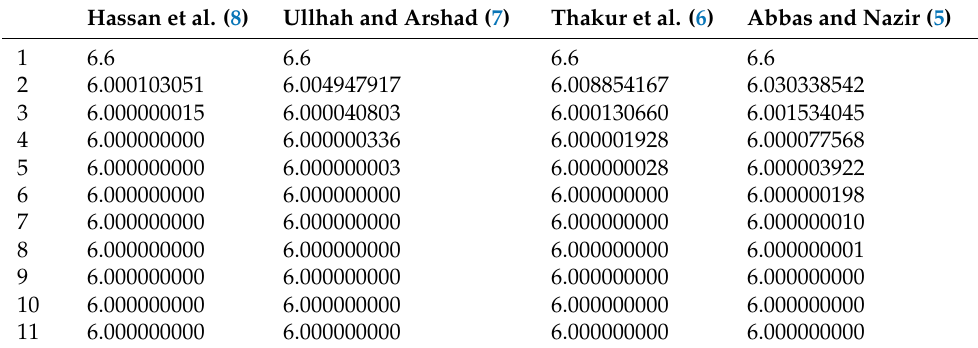
Table 1. Sequences generated by the different iterative processes for the RSTN selfmap T given in Example 1.